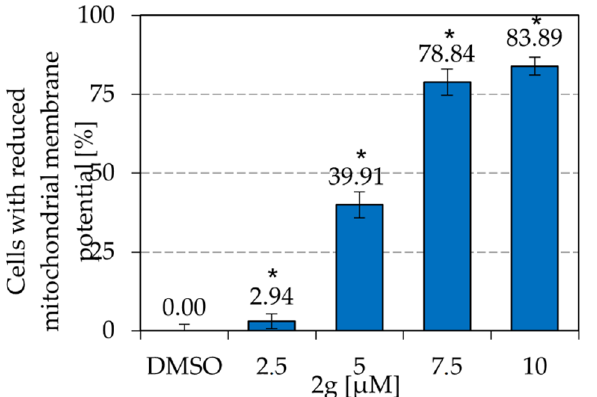
Figure 5. Reduction in mitochondrial membrane potential induced by 2g . Nalm-6 cells were incu- bated with different concentrations of 2g for 48 h. The percentage of cells with reduced mitochondrial membrane potential was determined using JC-1 staining and subsequent flow cytometric measurement. Three replicates were carried out per concentration. The mean values ± SD are shown (* p < 0.05 vs. DMSO, t -test).